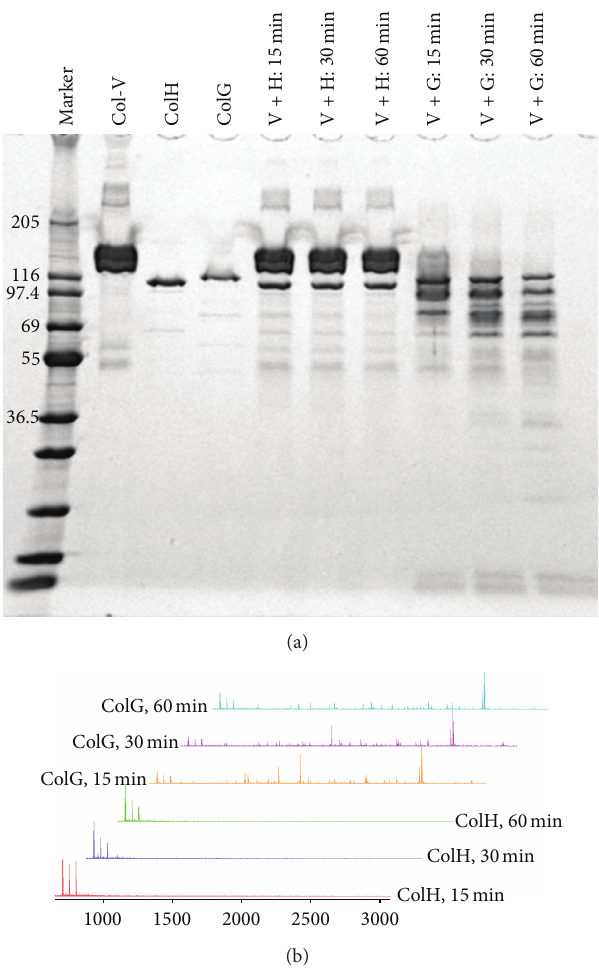
Figure 2: In vitro Col-V digestion by ColH and ColG. (a) SDS- PAGE analysis of digested Col-V. (b) MALDI-tof-MS analysis of the digestedsamplesat15,30,and60 min.Thepeakintensitiesarescaled to 100% for the most intense peak in each